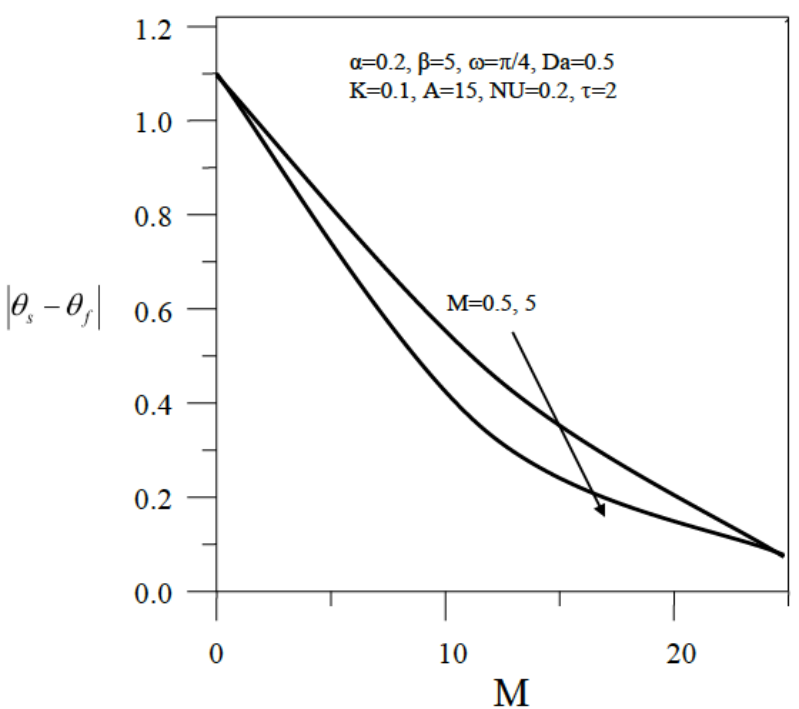
(cid:12) (cid:12) (cid:12) θ s − θ f (cid:12) ) against magnetic field parameter ( M ), pre-